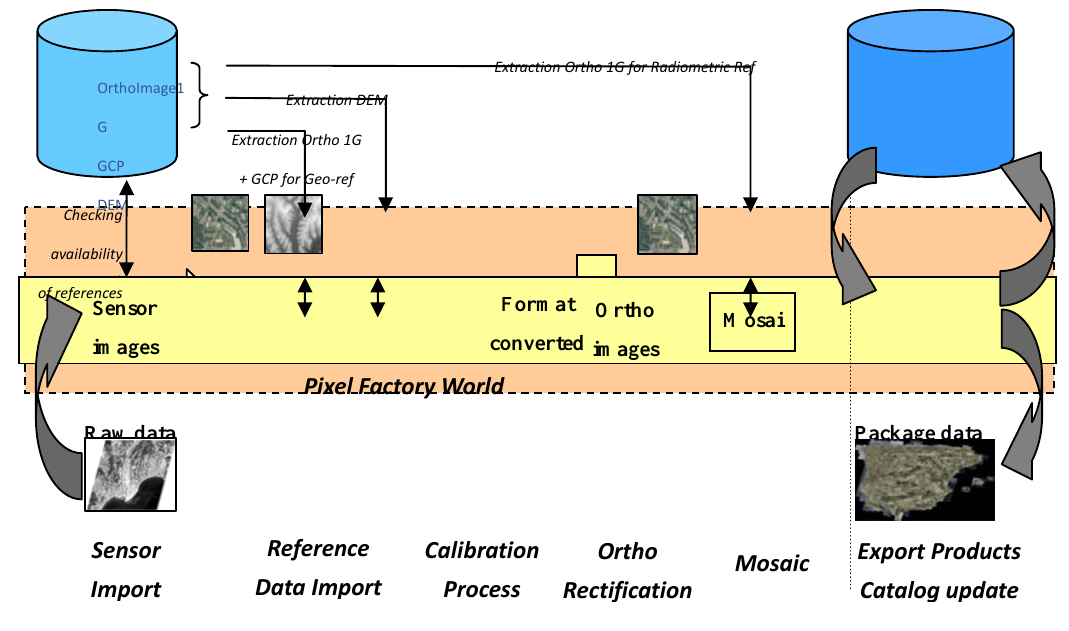
Figure 1. Second Mosaic Generation (SGM)